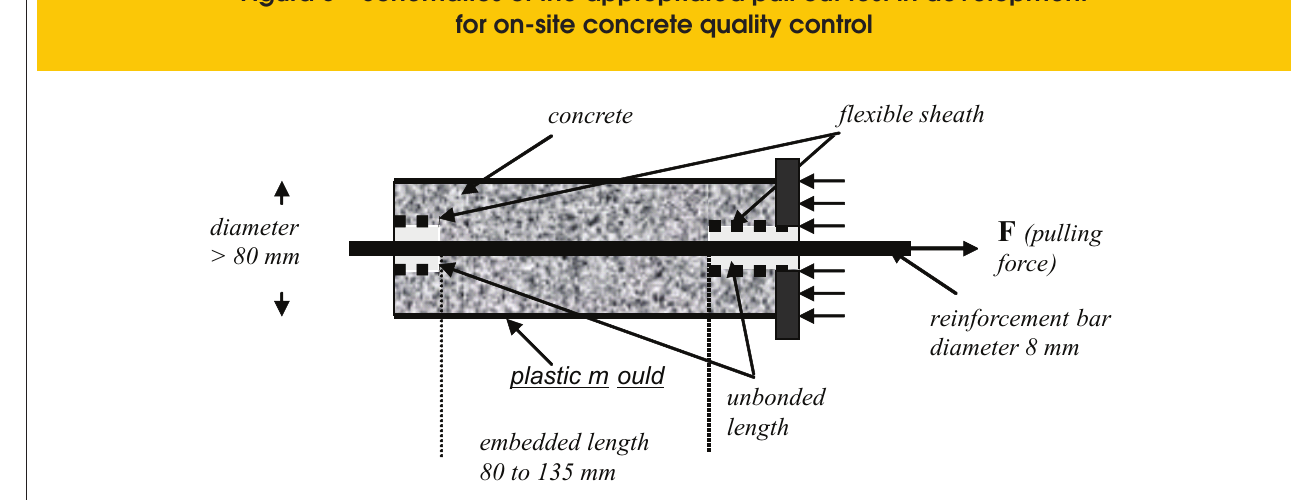
Figura 3 – Schematics of the appropriated pull out test in development for on-site concrete quality